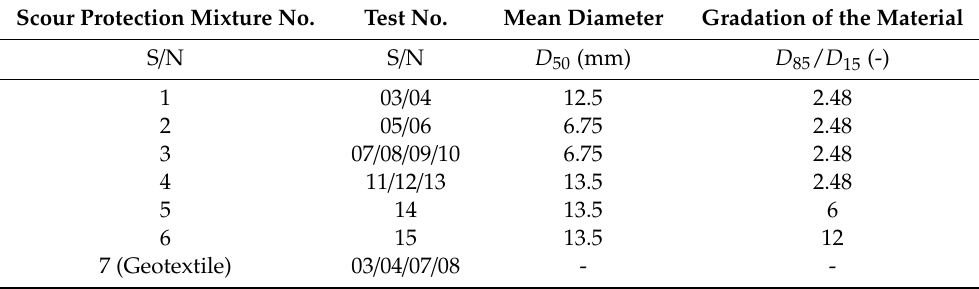
Table 6. Properties of scour protection composition and indication of